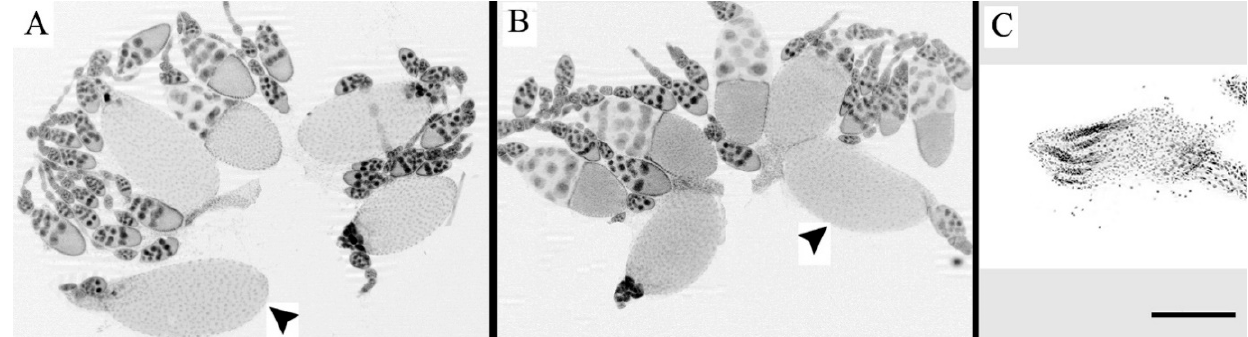
Figure 1. Ovarian morphology of F1 females. ( A ) Ovaries of ♀ H ♂ C-S (non-dysgenic) females after incubation at 29 °C. Ovary contains eggs chambers at different stages of oogenesis and eggs (arrowhead). ( B ) Ovaries of ♀ C-S ♂ H (dysgenic) females at 20 °C. They also have normal morphology. ( C ) Ovaries of ♀ C-S ♂ H (dysgenic) females at 29 °C. Oogenesis does not occur and eggs do not develop. Example of one of 25 flies per each cross and each temperature. Nuclei are stained by DAPI. Scale bar: 12 µm.